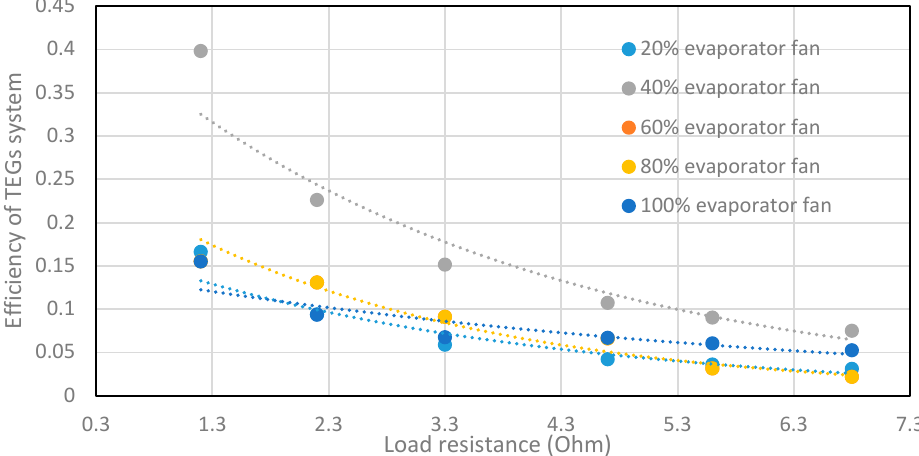
Figure 11. Variation of TEGs power with load resistance at different values of evaporator load.